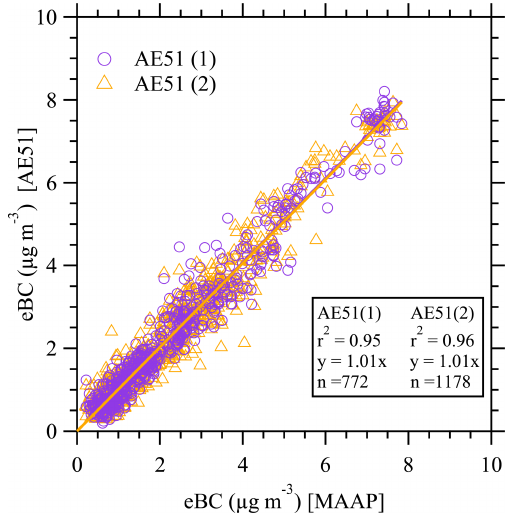
Figure 7. Correlation between the two AE51s (in 1min average) aboard the aerosol backpacks against the reference absorption pho- tometer MAAP during the intercomparison